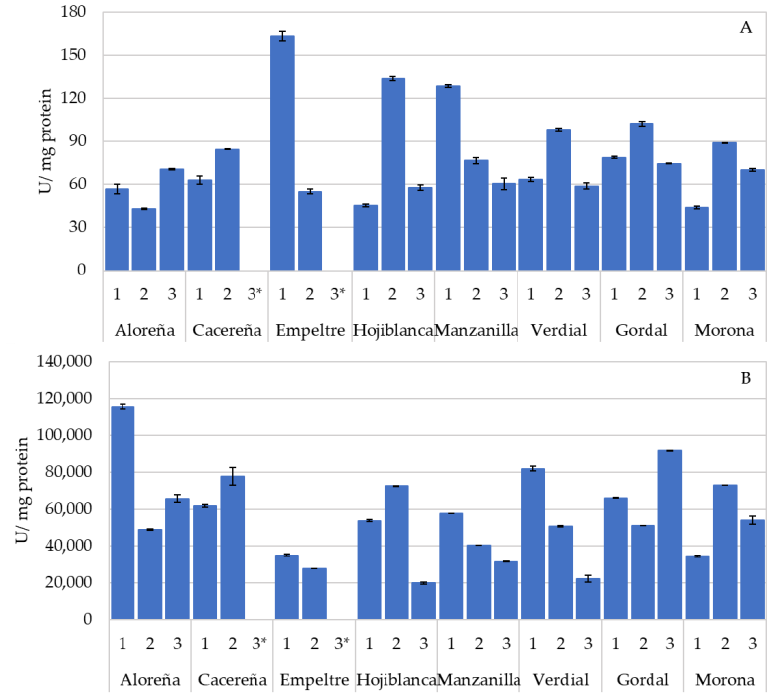
Figure 2. Oxidase enzymatic activity (U/mg protein) in olive leaves of Aloreña, Cacereña, Empeltre, Hojiblanca, Manzanilla, Verdial, Gordal and Morona varieties. Panel ( A ) corresponds to polyphenol oxidase activity. Panel ( B ) corresponds to peroxidase activity. Data are means of duplicates. Vertical bars mean the standard deviation. * Data not available.